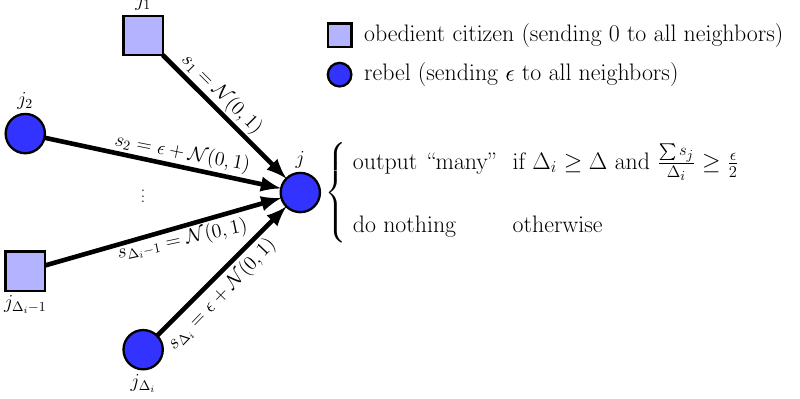
Figure 1. The Quorum-Sensing protocol with parameter ε . Rebels send the number ε > 0 to all their neighbors, and obedient citizens send the number 0. Rebel i receives signals from its (cid:31) i neighbors (a combination of rebels and obedient citizens), and decides whether to output “many” according to the rule specified on the right ( (cid:31) denotes the median